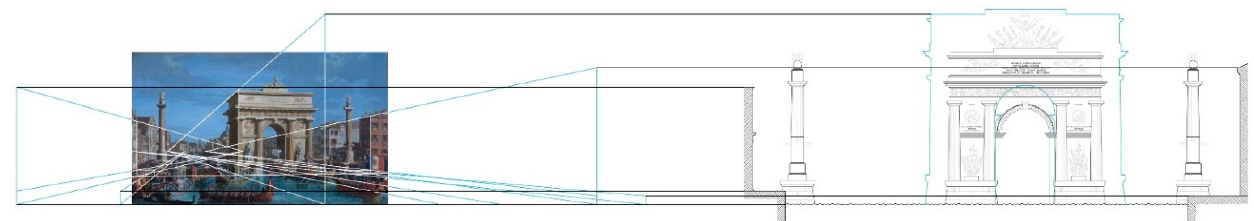
Figure 15. The restitution of the height of the arch, buildings, and foundations.